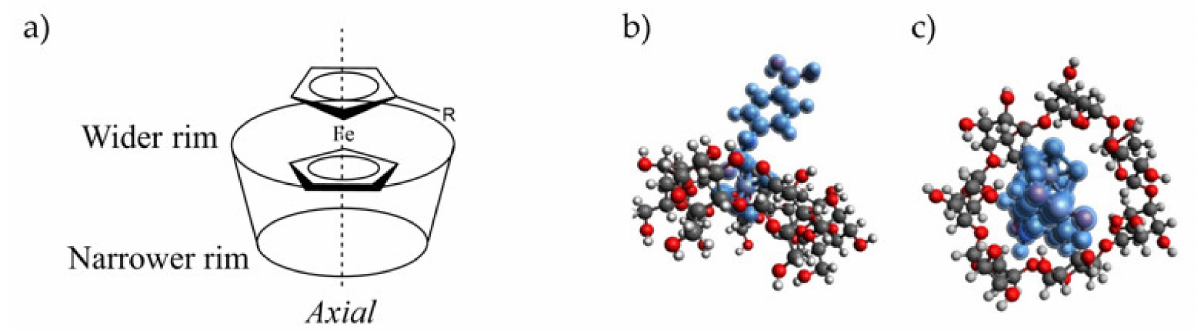
Figure 3. ( a ) The axial orientation of derivatized ferrocene inside a cyclodextrin cavity; ( b ) the side and ( c ) top view of a 3D molecular representation of the 4-Fc-PB probe in a natural β -CDs